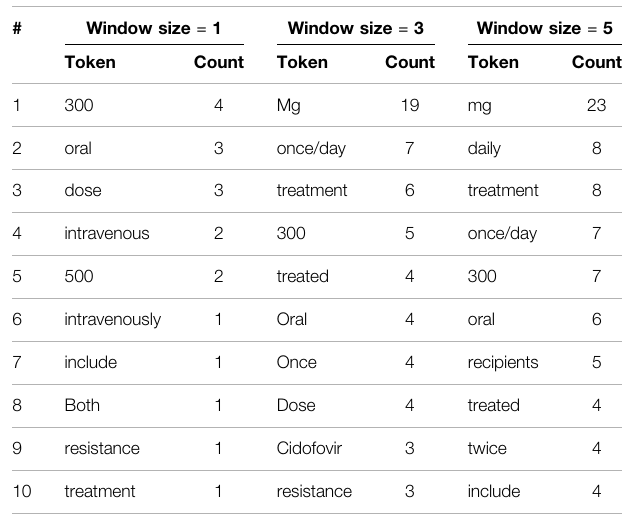
TABLE 3 | The 10 most frequent tokens, excluding stopwords and punctuation marks, within various window sizes around entities incorrectly labeled by human